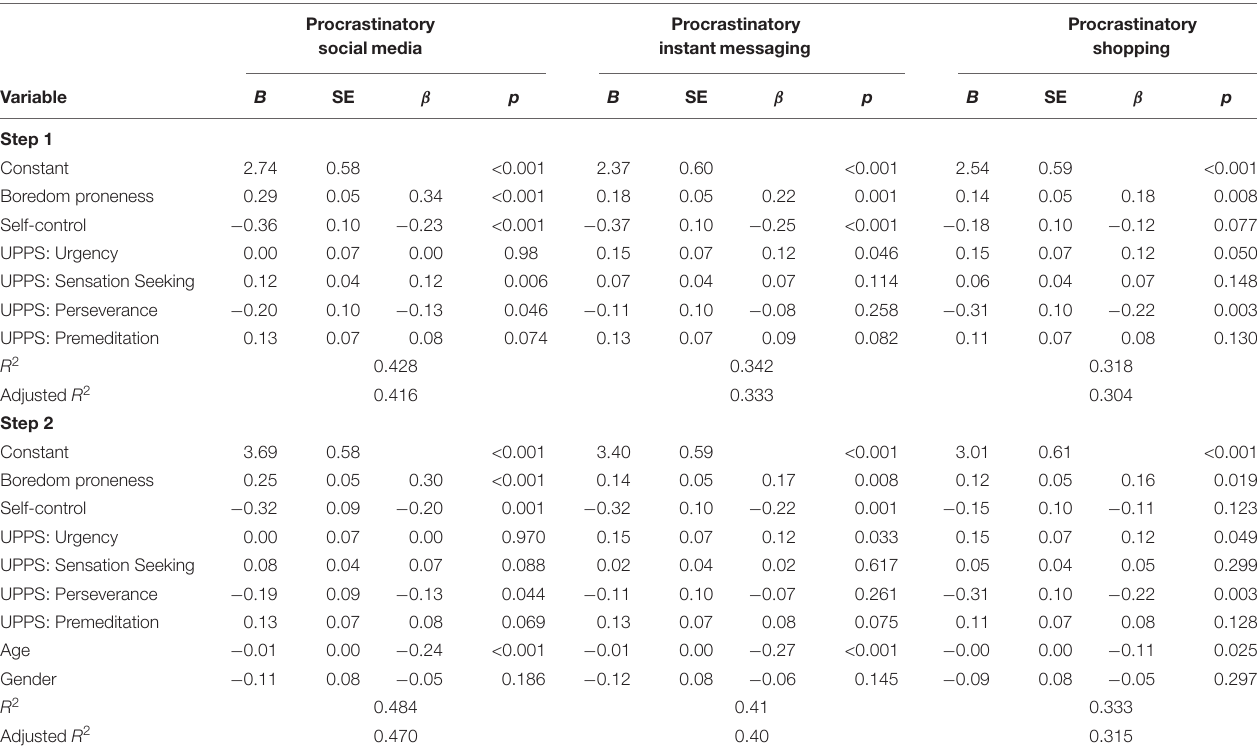
TABLE 5 | Hierarchical regressions predicting online procrastination in the German